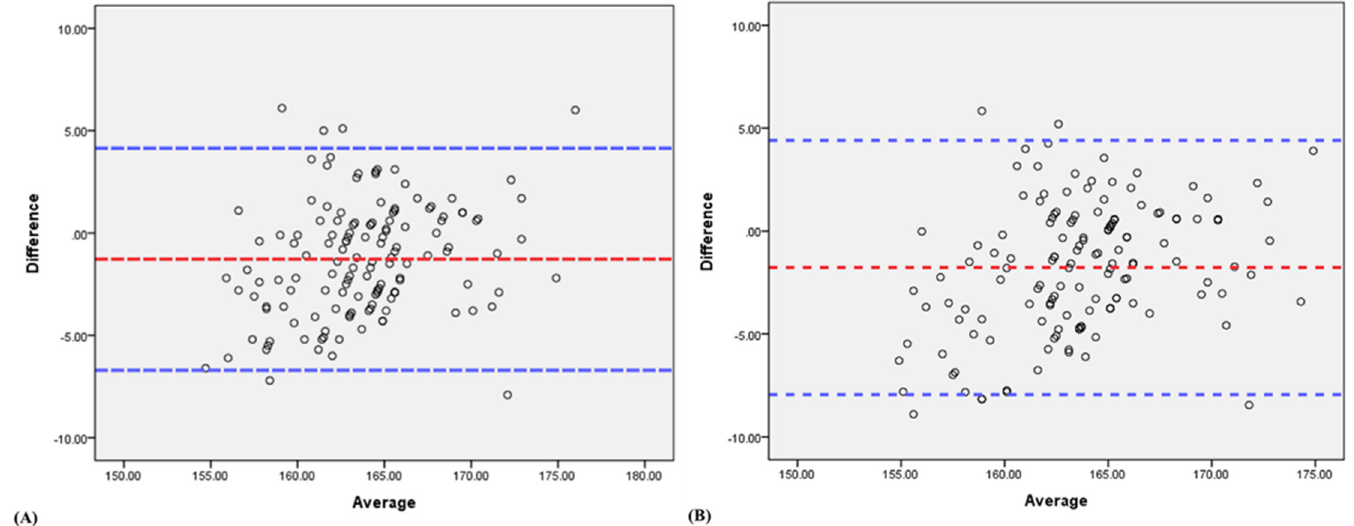
Fig 7. Bland – Altman plot (B-A plot) used to assess the agreement between two measurement methods. (A) Radiologist A vs. MI. (B) Radiologist B vs. MI. The X-axis is the average of the measurements, and the y-axis is the difference between the two